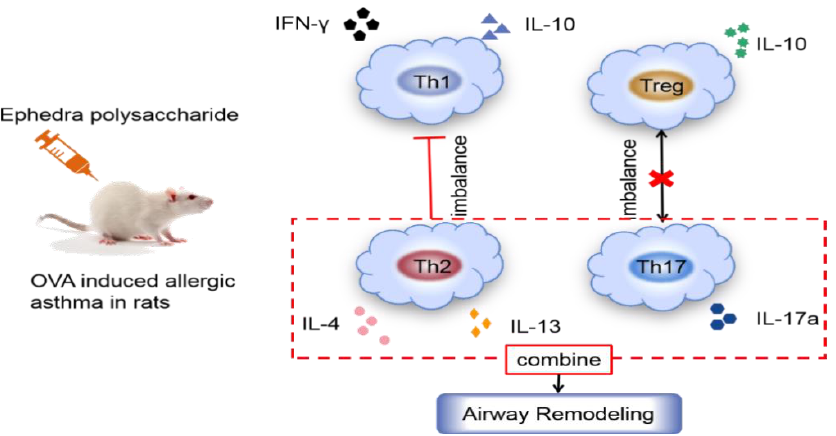
Figure 2. Ephedra polysaccharide regulates OVA-induced inflammatory response in asthma.